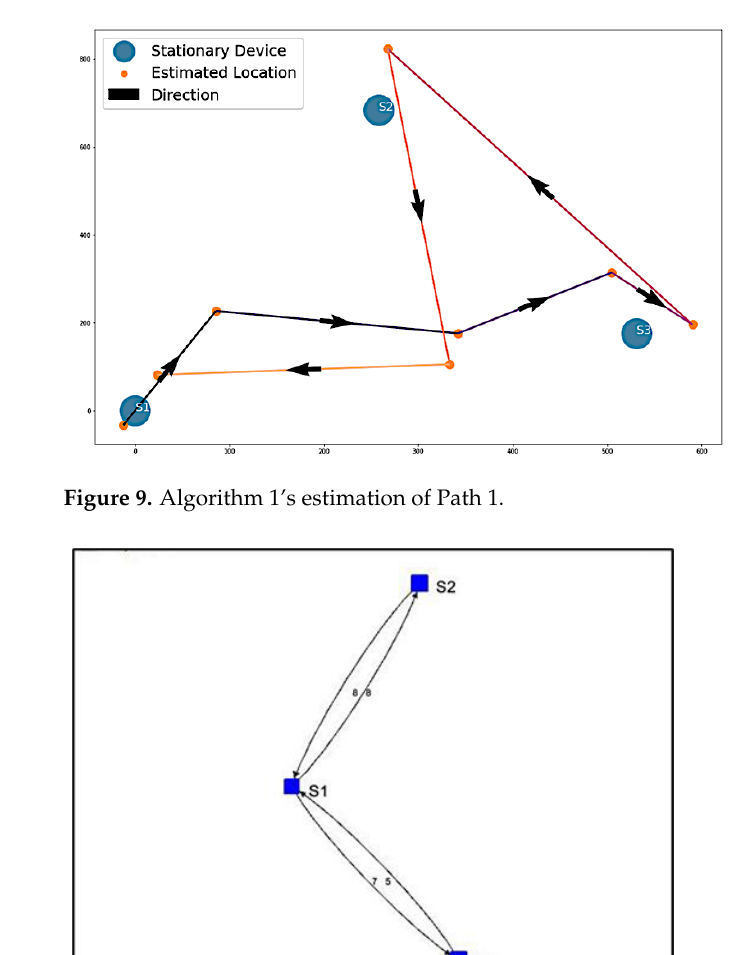
Figure 10. Algorithm 2 ’ s visualization of Path 1 vectors.